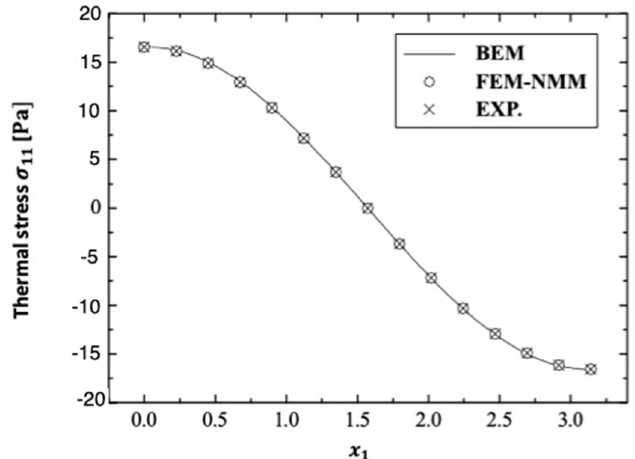
Figure 14. Distribution of the thermal stress wave σ 11 along x 1 –axis in the special case of anisotropic FRP composites for BEM, FEM-NMM, and Exp.